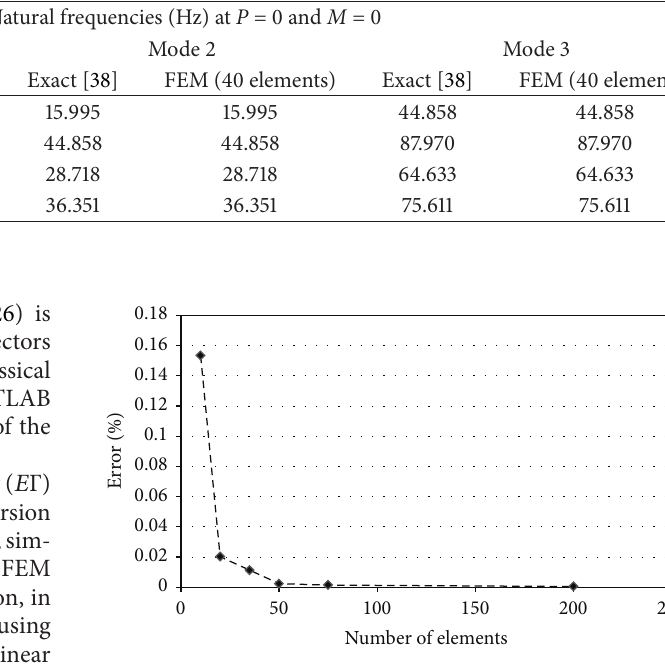
Figure 3: FEM convergence analysis; the fifth natural frequency of preloaded cantilevered